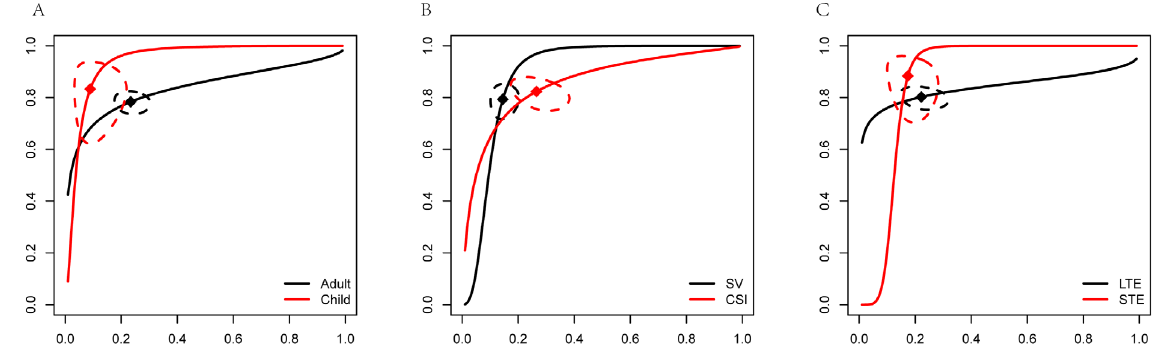
Figure 4. SROC curve of diagnostic performance of stratified meta-analysis. (A) Adult and child. (B) SV and CSI. (C) LTE and STE.